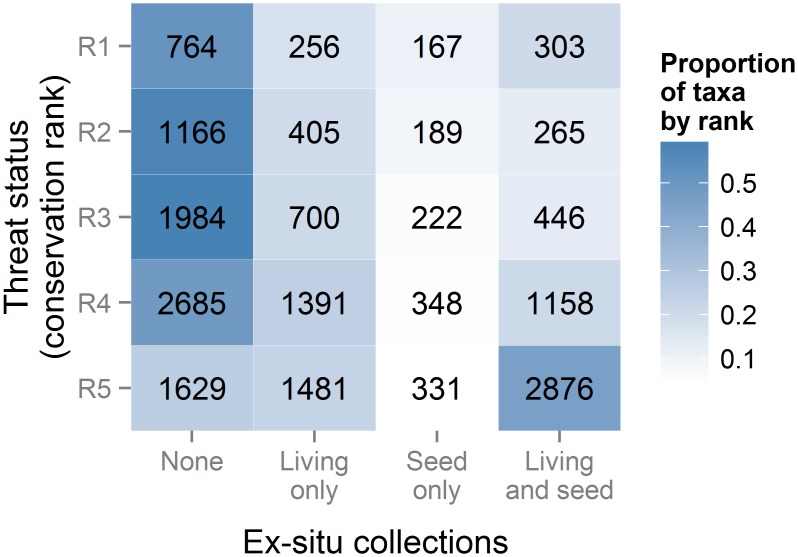
Distribution of ex situ collections for North American angiosperm taxa by threat rank.Numbers in cells are numbers of taxa of each collection status, which differed by threat rank (Χ2 = 2203, P << 0.0001). Shading indicates the proportion of taxa within a threat rank with a given ex situ collection status.